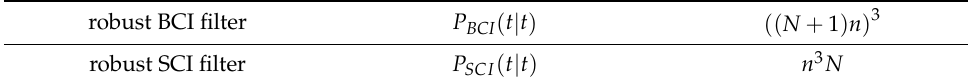
Figure 1. The structure of the SCI fusion robust Kalman filter. Table 2. The comparison of the computational loads.